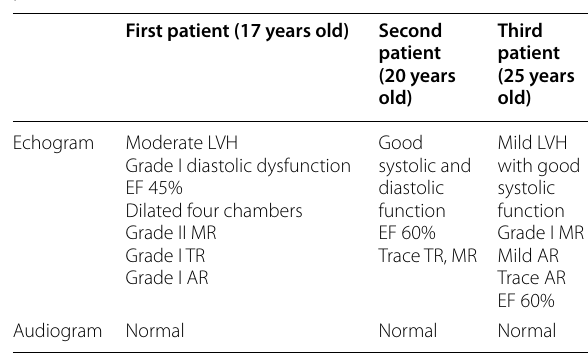
Table 3 Cardiac echogram and audiogram results of